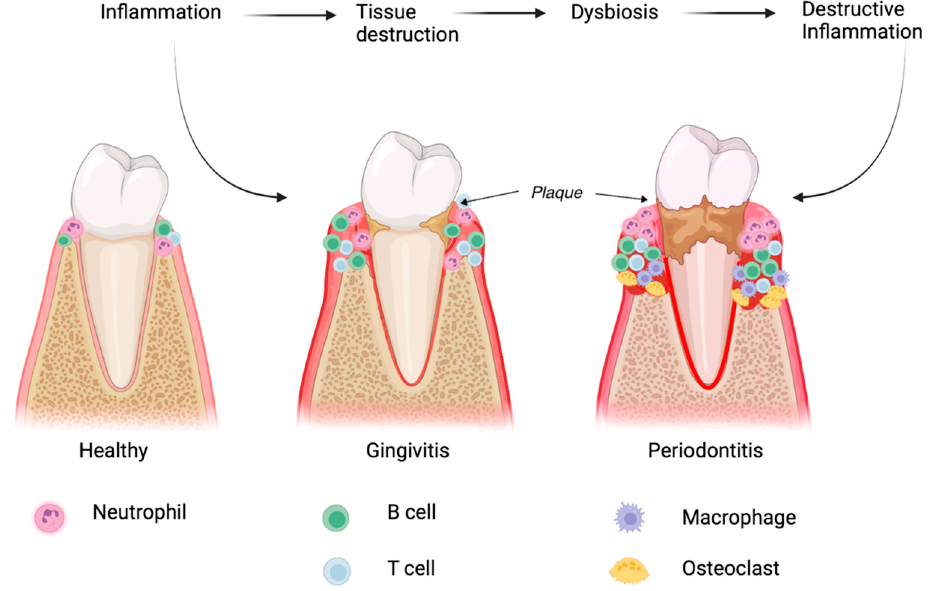
Figure 1. The role of dysbiosis in the development of periodontitis. The figure shows the influence of bacterial plaque in the development of periodontal disease (the brown spot around the tooth neck) as well as the immune response of the host (the types of cells that develop at the periodontal